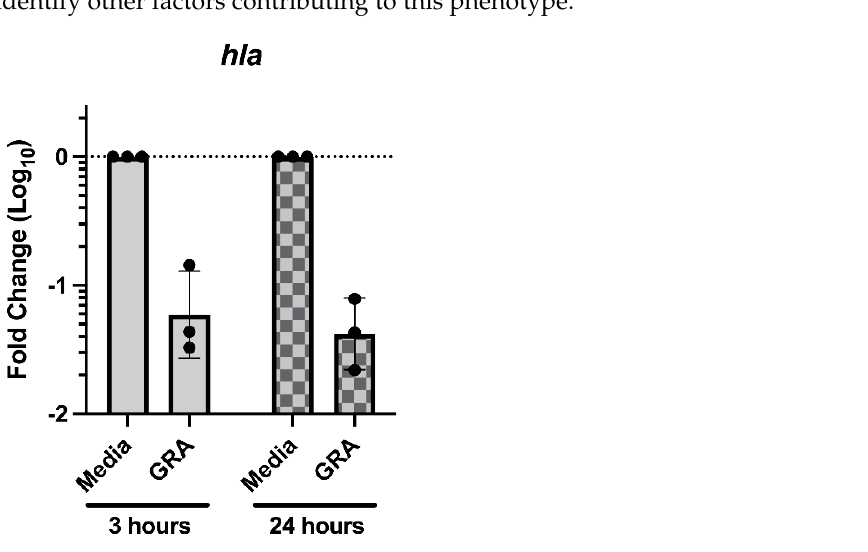
Figure 7. Treatment with GRA reduces biofilm hla transcript abundance. Static biofilms were grown for 24 h prior to media replacement with 62.5 mg/L GRA or DMSO control. RNA was isolated at 3- or 24 h post-treatment. Transcript abundance was evaluated using the 2 −ΔΔ Ct method, normalized to the expression of gyrase B ( gyrB ) housekeeping gene and calibrated to hla expression in media controls. Data displayed represent measurements from 3 biological replicates.